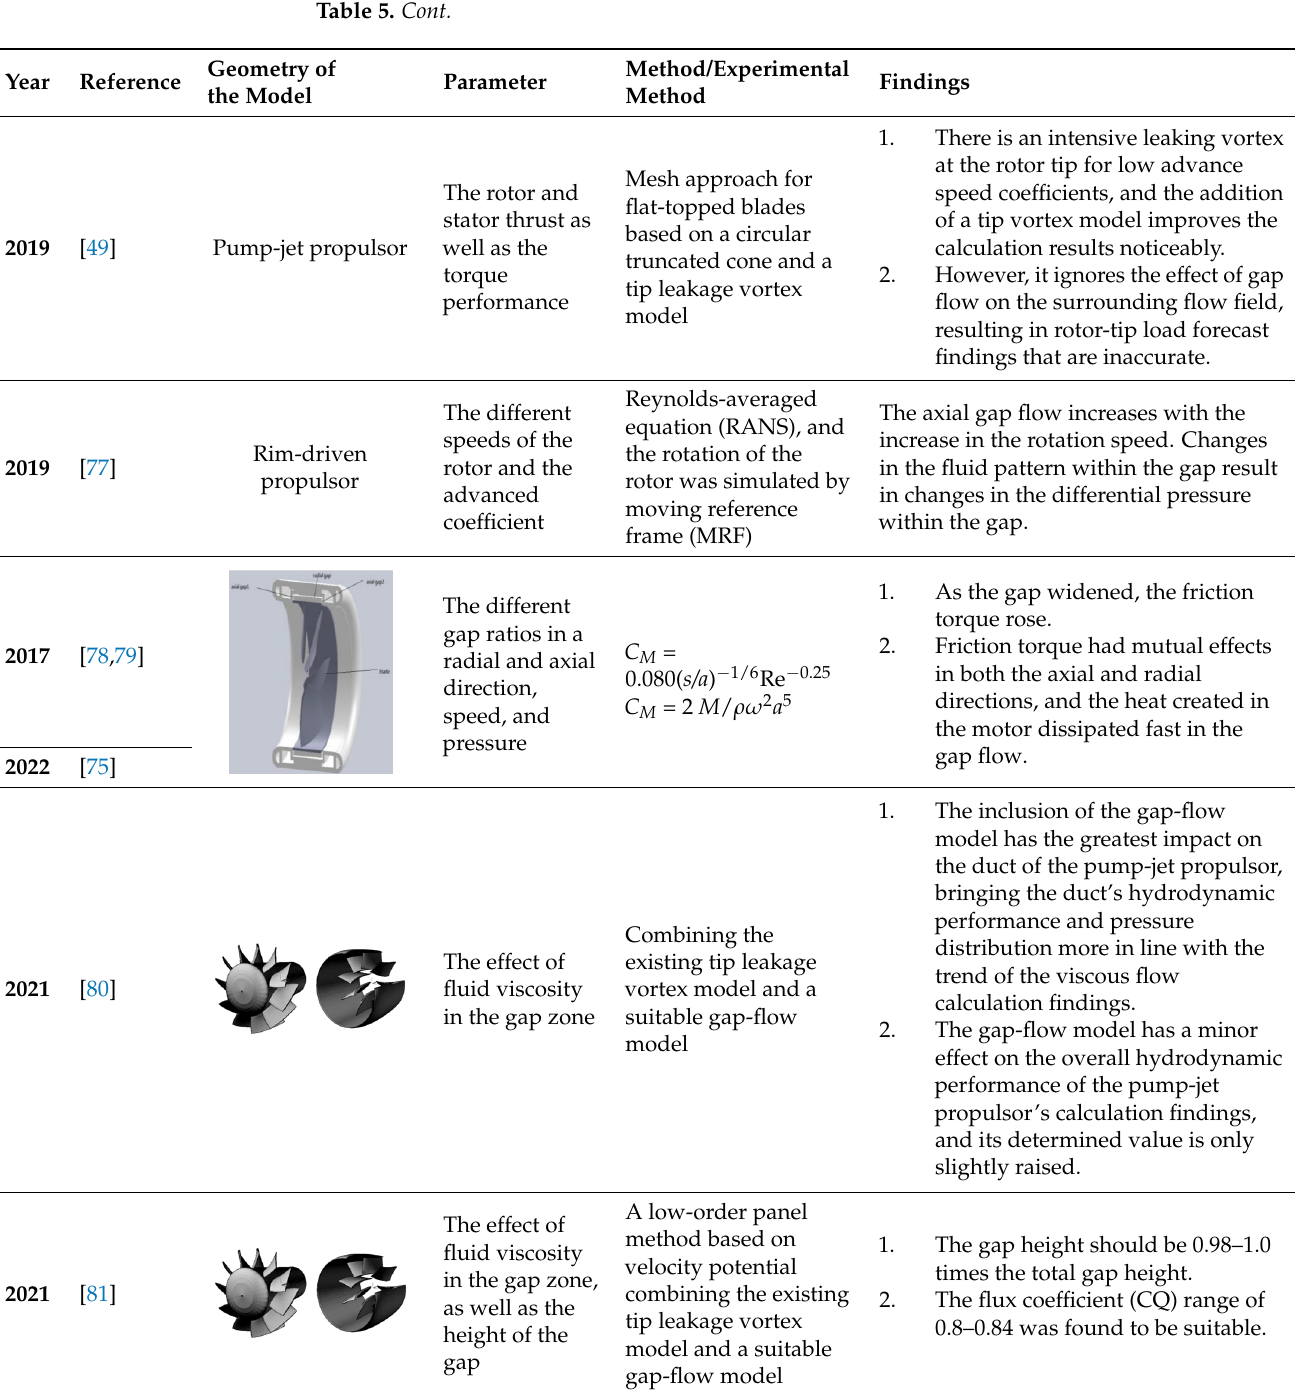
Figure 8. Interaction between duct and hull of a yacht: ( a ) yacht equipped with two RDTs; ( b ) water flow pattern behind the RDT [39]. To optimize the structure and installation site of RDTs, it is critical to comprehend the interaction and nonlinear coupling between the wakefield, the RDT, and the hull. The efficiency of the system can be improved while minimizing sailing resistance by optimiz- ing the RDT design, hull lines, and installation sites. To study the interactions between the hull and RDTs, Lu et al. (2014) [82] investigated the influence of the number of RDTs (ei- ther two or four sets) and the location of the RDT installation on the hydrodynamic per- formances of an underwater vehicle (Figure 9). Due to the influence of the stern wake, reducing the distance between the RDT and the hull improved the RDT’s efficiency and the thrust deduction factor. To increase the vehicle’s hydrodynamic performance, the RDTs could be placed at the parallel middle body towards the aft body. This would result in a negative thrust deduction factor. When RDTs were installed on the stern planes, in- creasing the number of RDTs resulted in a significant reduction in the total propulsive efficiency; however, when the RDTs were mounted on the parallel middle body, there was